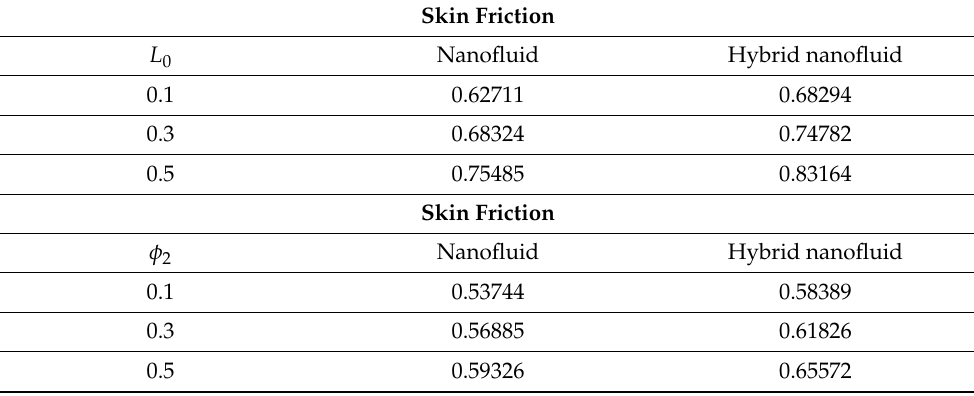
Table 3. Evaluations of SF for numerous values taking 𝑃𝑟 = 5, 𝐵𝑣 = 0.5, 𝑀 𝑑 = 10 fixed.